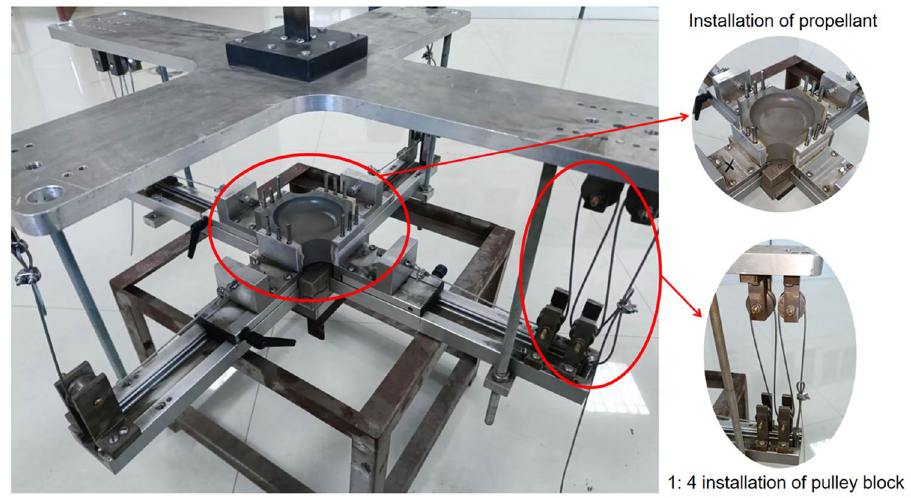
Figure 6. Assembly diagram of propellant test piece and test fixture under 1:4